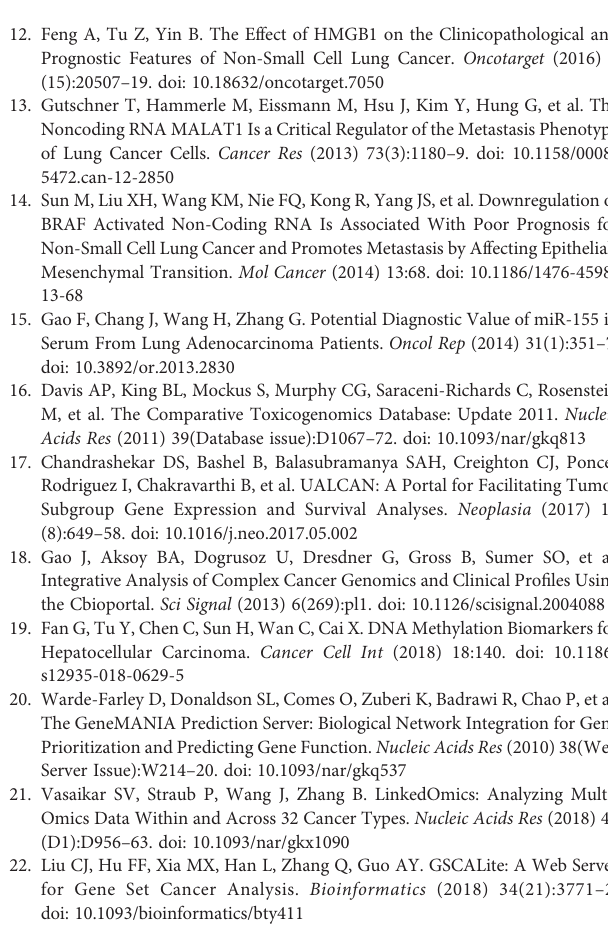
Supplementary Figure 1 | PPI network of correlations genes with CLEC9A in LUAD. (A) Positive correlations genes. (B) Negative correlations genes. Supplementary Figure 2 | KEGG pathway of correlations genes with CLEC9A in LUAD. (A) Positive correlations genes. (B) Negative correlations genes. Supplementary Figure 3 | Overexpression of CLEC9A inhibits LUAD cell proliferation. (A) Transfection ef fi cacy were detected by RT-qPCR. (B) MTT assay revealed the viability of LUAD cells was suppressed by overexpression of CLEC9A. *P < 0.05, **P <